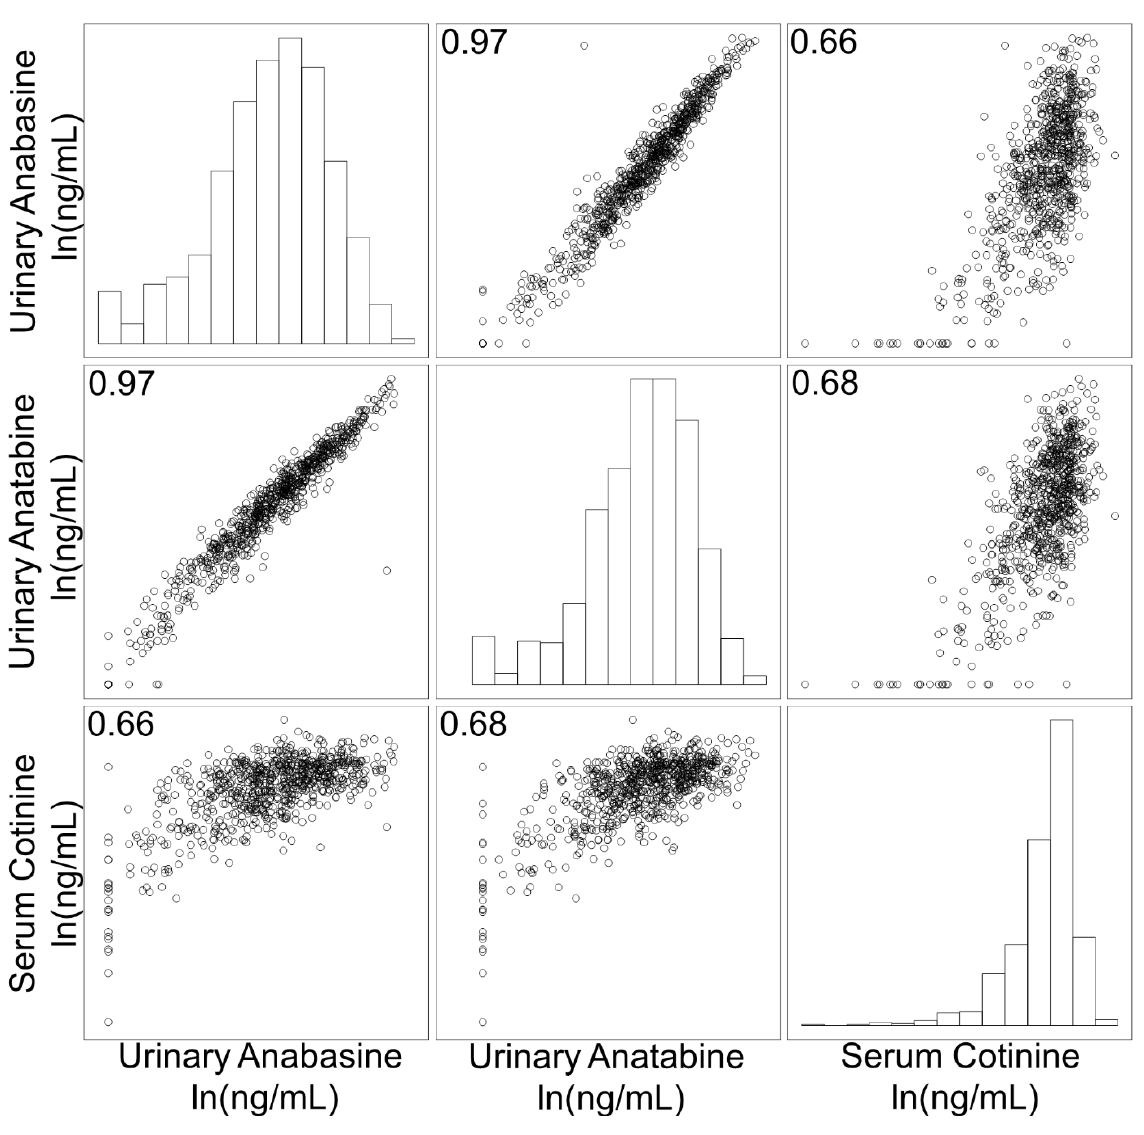
Figure 1. Correlation plot of the natural log of urinary anabasine, urinary anatabine, and serum cotinine levels.